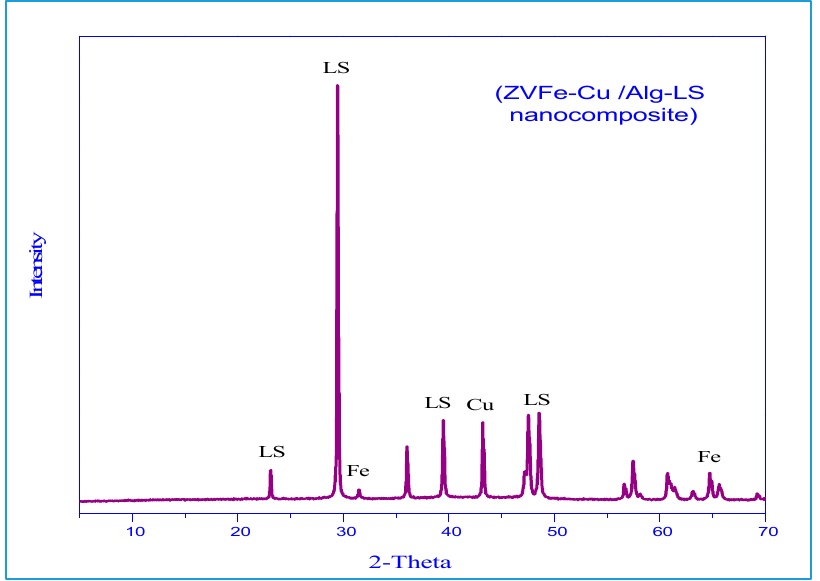
Figure 2. XRD of the Fe–Cu/Alg–LS nanocomposite.